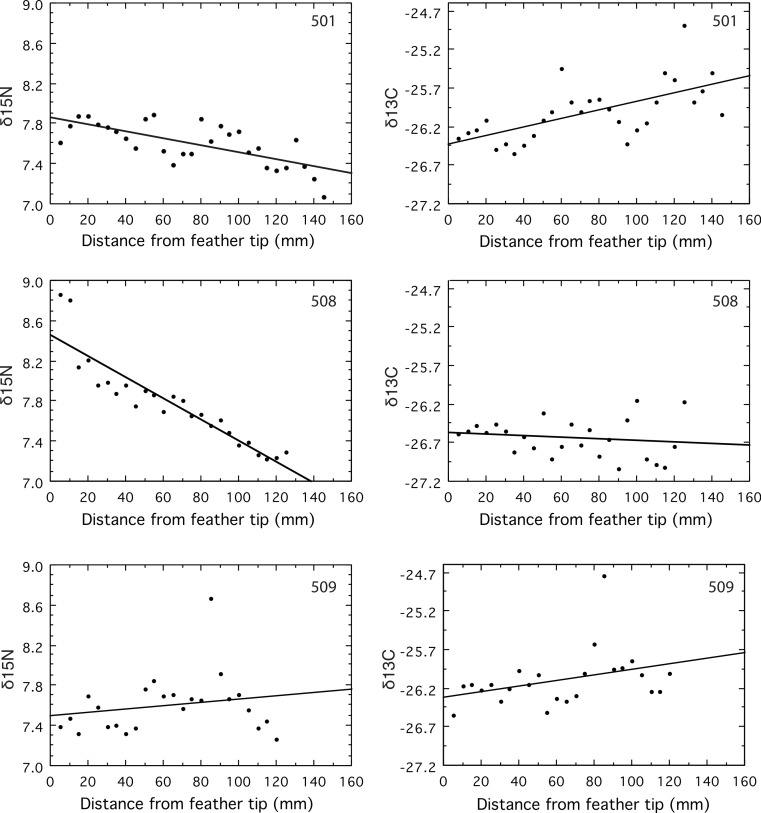
Values for δ15N and δ13C measured in serial samples along the length of the primary.Feather vein was sampled at 5 mm intervals near the rachis of the growing primary for its full length, starting at the tip of the feather.